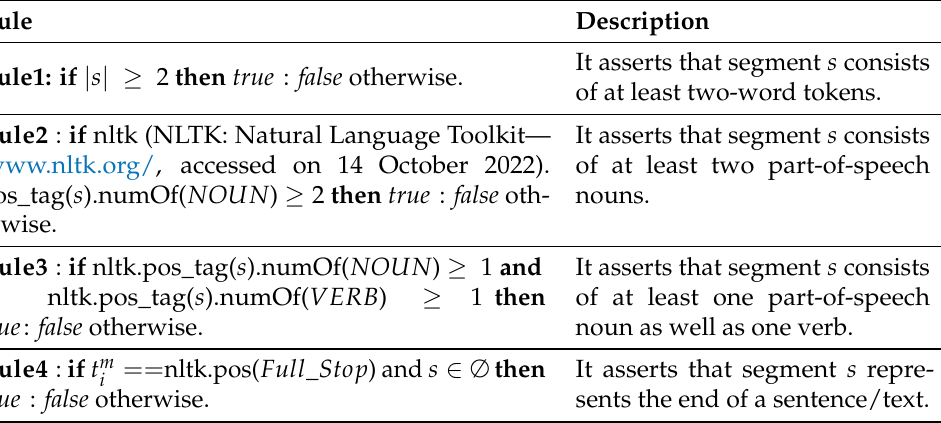
Table 2. Our generic linguistic rules (represented as IF-Then block), used in PDTS to validate the detected